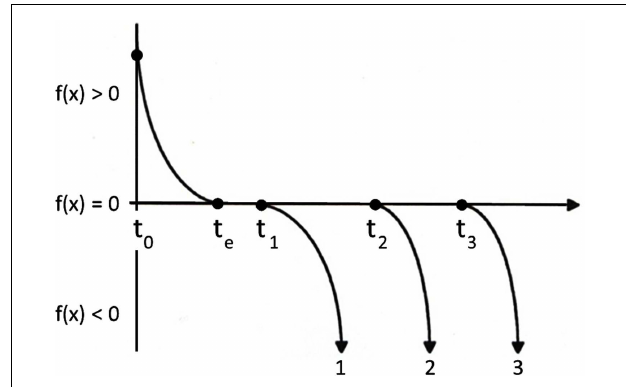
FIGURE 6 | Global (left) and local (right) recurrence plots of monthly sun spot activity from May 1874 to September 2005 (131years, 5months) obtained from the Royal Greenwich Observatory. Twelve cycles of 11years each are duplicated as time series beneath the recurrence plots.With a delay of 1 and embedding dimension of 1, the distance matrices are scaled from 0 to 100%.With the threshold set to 100% (left) the entire matrix is plotted in 10 different colors representing 10% steps (saturated, unthresholded recurrence plot).With the threshold set to 1% (right) only a fraction of the first step is plotted in a single color (sparse, thresholded recurrence plot).